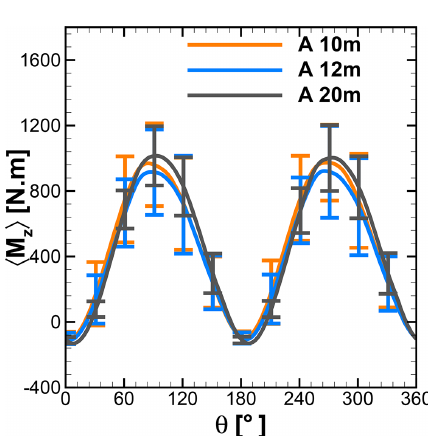
Figure 17. Normalized moment of a single blade in uniform inflow and in urban terrain at 10m height from rooftop of A. (Note: in the case of urban terrain, the moment is first averaged before normal- ized.)